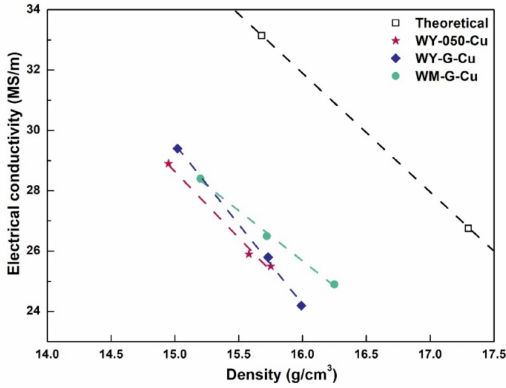
Figure 6. The electrical conductivity vs. density of the as-prepared W–Cu